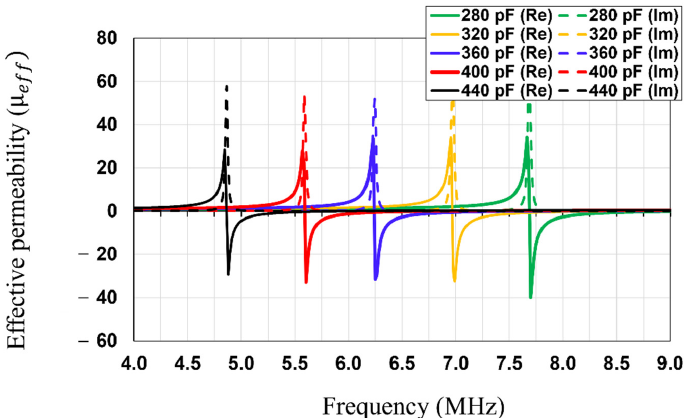
Figure 5. Simulated effective magnetic permeability of the MS screen with the various capacitor values.